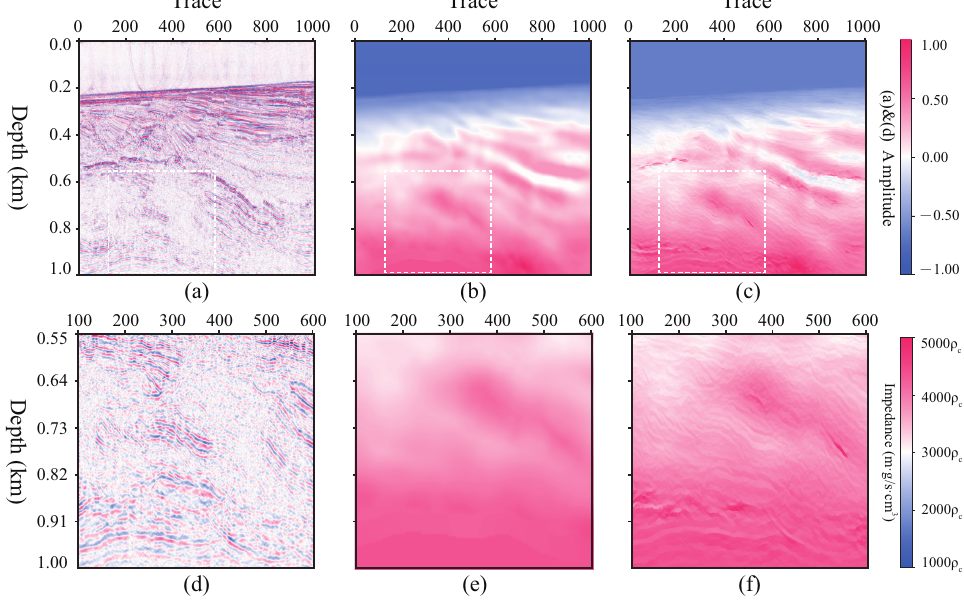
Figure 17. Result of inline No.750 slice. ( a ) The migrations. ( b ) The background impedance. ( c ) The prediction. ( d – f ) The zoomed-in area of ( a – c